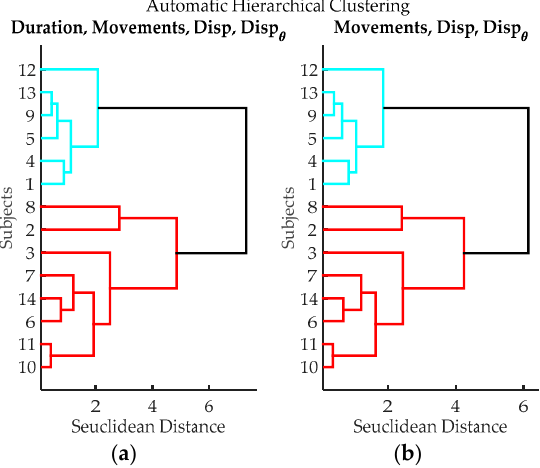
Figure 12. Dendrograms from cluster analysis of volunteers according to variables from data processing of IGlove data. ( a ) Clustering using Time of Exercise, Peaks quantity, spatial displacement and angular displacement; ( b ) Clustering using Peaks quantity, spatial displacement, and angular displacement.